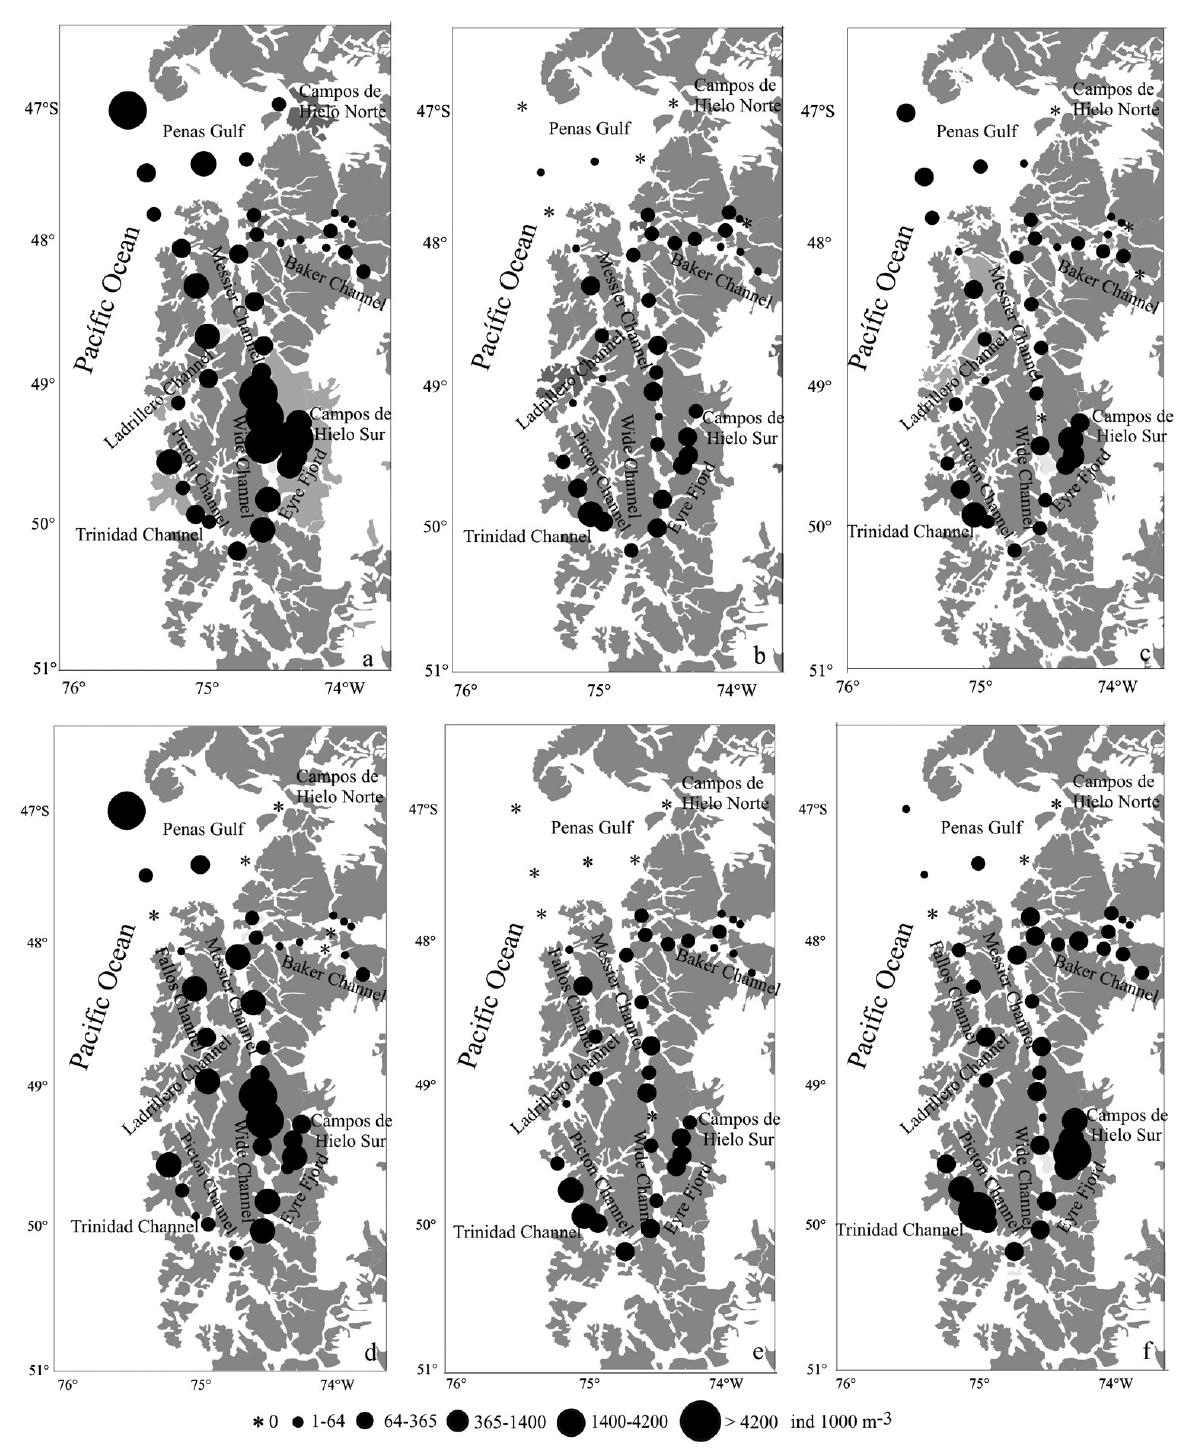
Fig. 3. – Spatial distribution in spring 2008 of polygastric stages of Muggiaea atlantica (A), Lensia conoidea (B), Dimophyes arctica (C), and eudoxids of M. atlantica (D), L. conoidea (E) and D. arctica